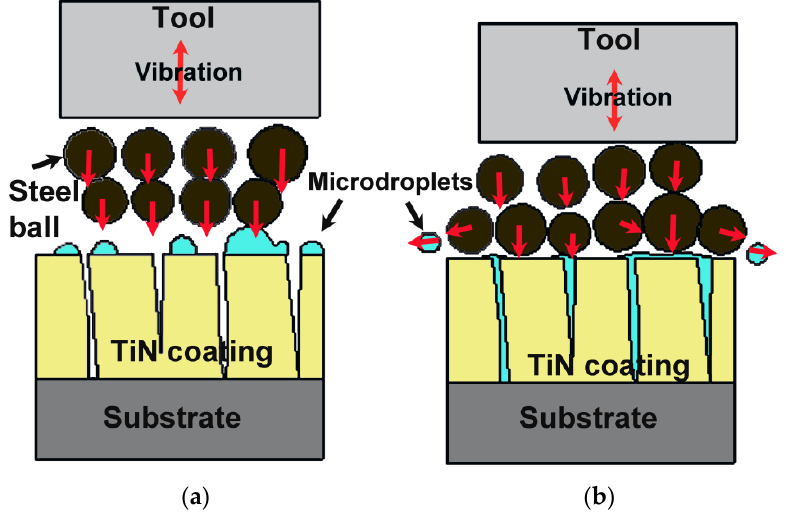
Figure 2. TiN-coated samples ( a ) before and ( b ) after being subjected to ultrasonic vibration.